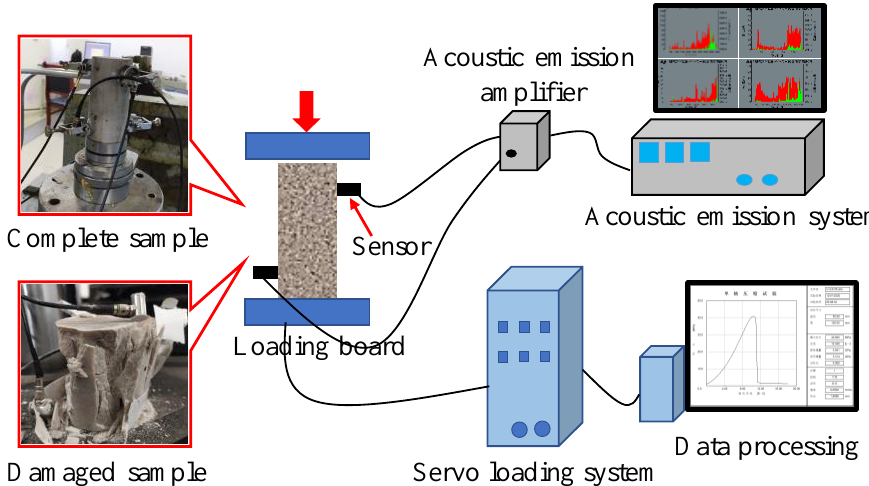
Figure 1. Schematic diagram of the loading of the test machine and the acoustic emission system. The test was divided into four groups. The height-to-diameter ratio (from now on, expressed as L/D) was 1.6, 1.8, 2.0, and 2.2. Each group of three rock samples, loading test process using stress control, axial pressure preload of 1 kN, loading speed of 1 kN/s until the sample damage. To investigate the effect of the height-to- diameter ratio on rocks’ mechanical proper- ties. Using the stress – strain curves of sandstone at different height-to-diameter ratios to explore the influence of changing height-to-diameter ratios on rock strength, deformation, and fracture patterns. The uniaxial compressive stress – strain curves of sandstone with different height-to-diameter ratios are shown in Figure 2.